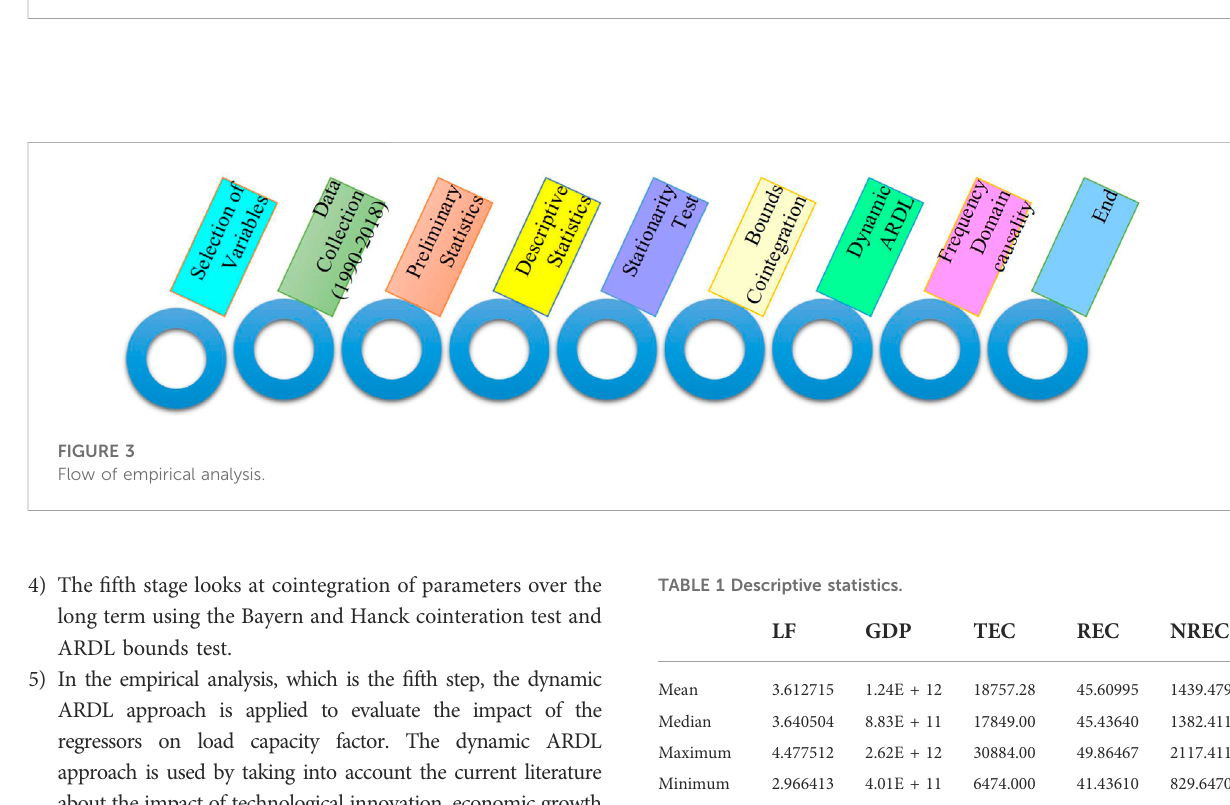
FIGURE 2 Load capacity factor determinants.